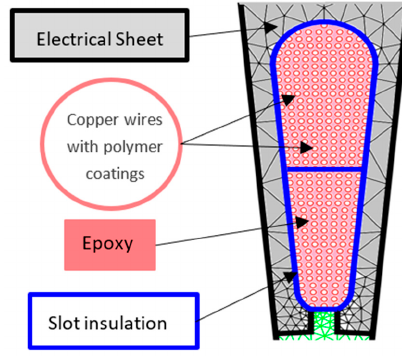
Figure 1. A general representation of a stator slot of an electrical machine with two layers of epoxy impregnated windings.